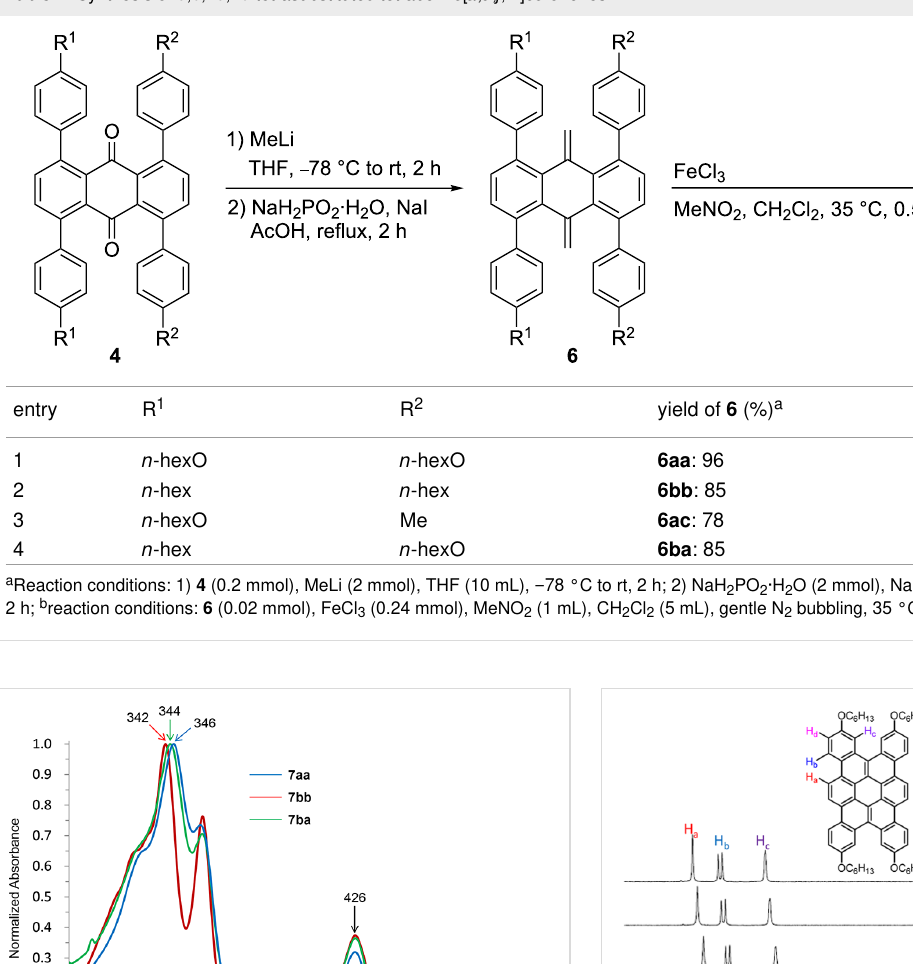
Table 1: Synthesis of 3,6,13,16-tetrasubstituted tetrabenzo[ a , d , j , m ]coronenes.